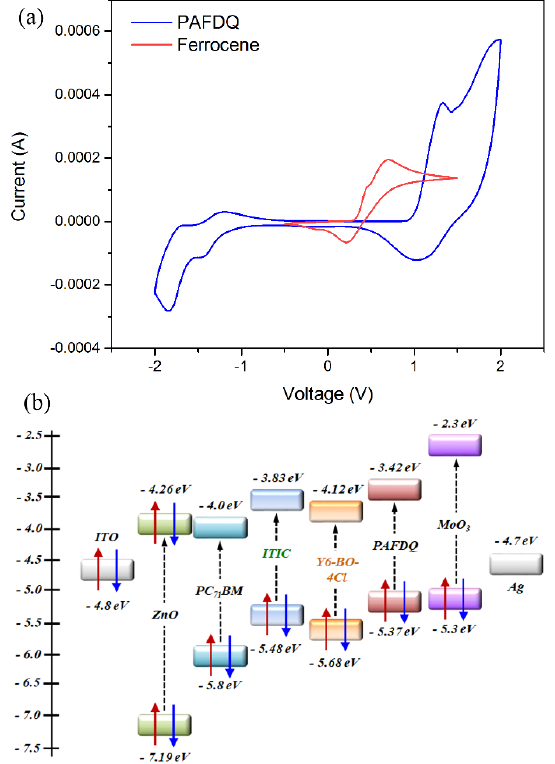
Figure 2. ( a ) Cyclic voltammogram of polymers with a 0.1 M acetonitrile (substituted with nitrogen for 5 min) solution ( b ) band diagram of polymer (experimental data), ITO, ZnO, PC 71 BM, ITIC, Y6-BO −